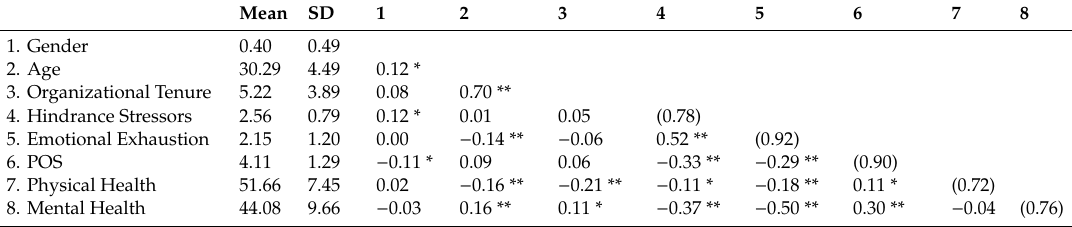
Table 2. Means, standard deviations, and correlations among